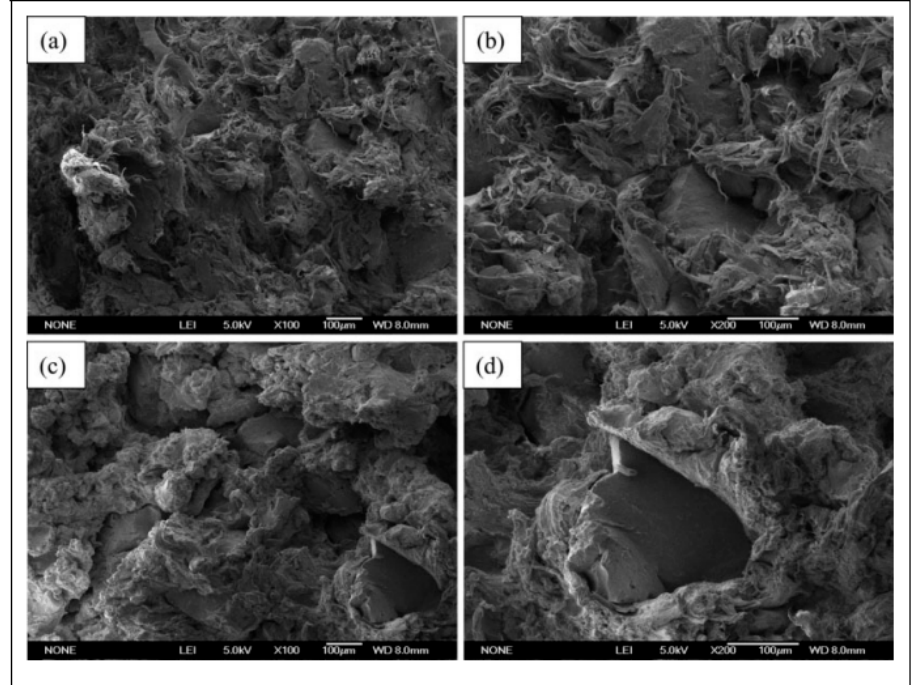
Figure 11. Fractured surfaces of HDPE / SBS / GTR compounds prepared by melt compounding (extrusion). The compositions (weight ratio) are: ( a ) 30 / 0 / 70, ( b ) 30 / 0 / 70, ( c ) 30 / 12 / 70 and ( d ) 30 / 12 / 70 (reproduced with permission from [23]).